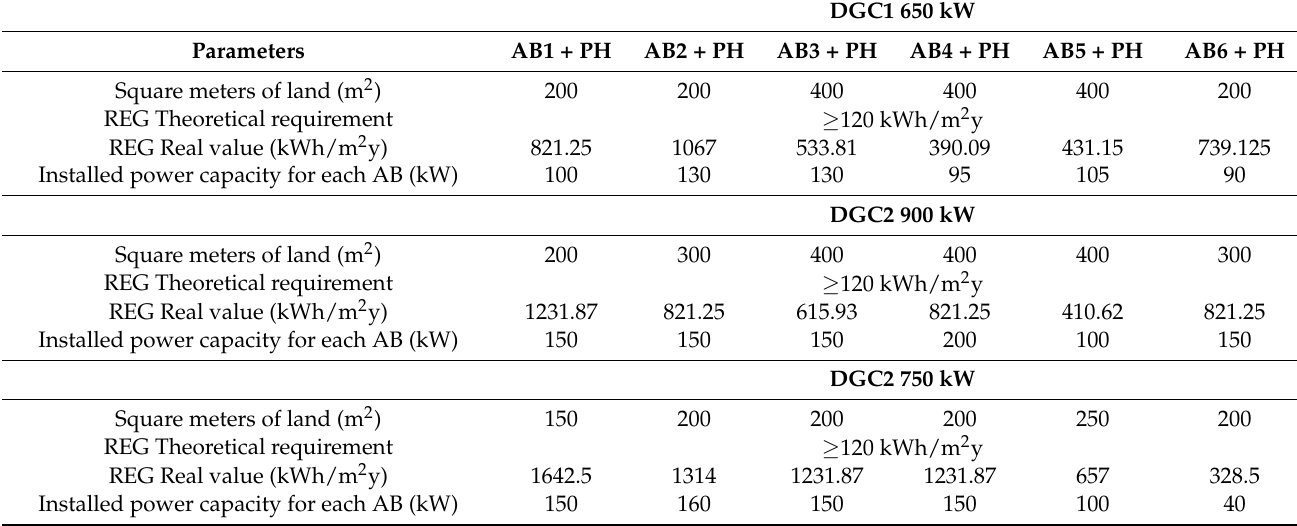
Table 5. Energy generation by each Active